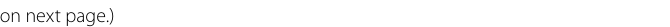
figure on next Fig. 3 Effects of simvastatin and geranylgeranyl pyrophosphate (GGPP) on localization of di-phosphorylation of myosin light chain (ppMLC) and actin bundle formation in porcine aortic endothelial cells (PAECs). a Representative merged images of confocal microphotographs show the triple fluorescence staining of either F-actin/VE-cadherin (VE-Cad)/nuclei (DAPI) or ppMLC/VE-Cad/DAPI in PAECs in the indicated colors. The extracted images of ppMLC and actin (both in a green channel) in a gray scale are shown below the corresponding merged images. The readings of the fluorescence intensity were indicated at a lower right corner of each image. b Summaries ( n 3) of quantitative analysis of fluorescence = intensities of ppMLC and actin. The data are expressed as the mean SEM. * P < 0.05 according to an ANOVA followed by Fisher post hoc test. ± PAECs were either pretreated or left untreated with 10 µM simvastatin for 16 h with and without co-treatment with 3 µM GGPP ( n 3). The images = were obtained 3 min after stimulation with 1 unit/mL thrombin. The cells were challenged to thrombin, in the presence of simvastatin and GGPP, when pretreated. Control indicates images of cells without any treatment. Thrombin induced peripheral accumulation of ppMLC and actin bundles in close proximity to VE-cadherin. Simvastatin inhibited the thrombin-induced peripheral accumulation of ppMLC and actin bundles, while co-treatment with GGPP prevented the simvastatin effects. The results obtained in the two additional sets of the experiments are shown in Additional file 1: Figure